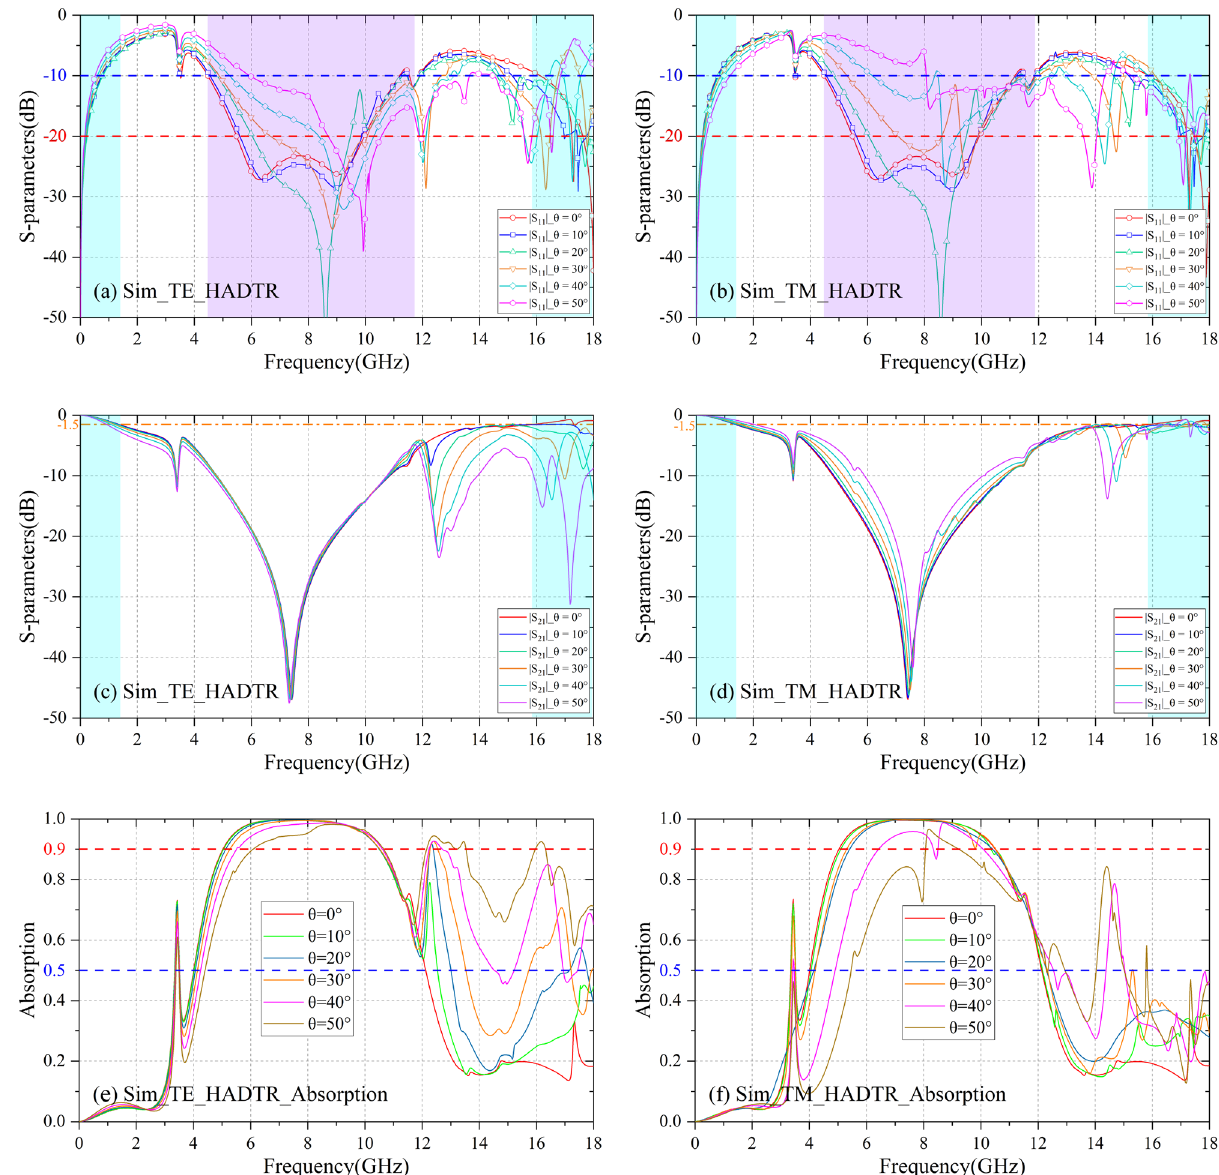
Figure 8. Simulation results the proposed HADTR. ( a , b ) At TE/TM polarization, reflection coefficients under different oblique incidences. ( c , d ) At TE/TM polarization, transmission coefficients under different oblique incidences. ( e , f ) At TE/TM polarization, absorptivity under different oblique incidences.